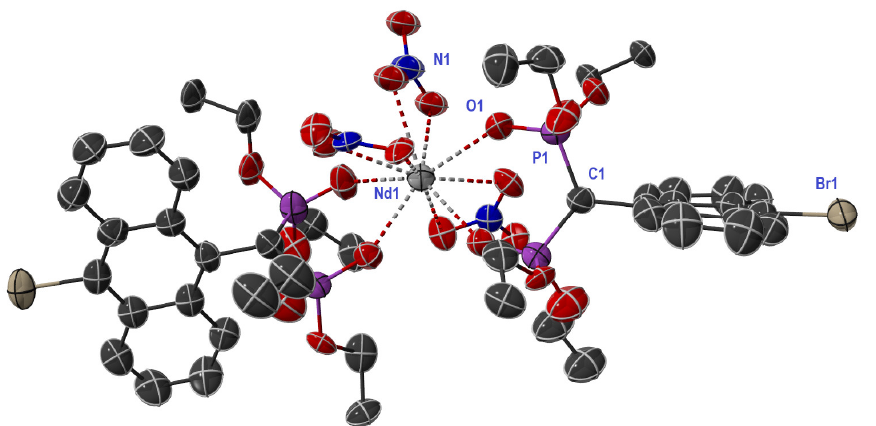
Figure 1. The molecular structure of complex [Nd( L3 ) 2 (NO 3 ) 3 ] ( 5 ) which is isostructural to the solid-state structure of lanthanum(III) derivative [La( L3 ) 2 (NO 3 ) 3 ] ( 6 ). Anisotropic displacement parameters are depicted at the 50% probability level. Hydrogen atoms are omitted for clarity. Symmetry